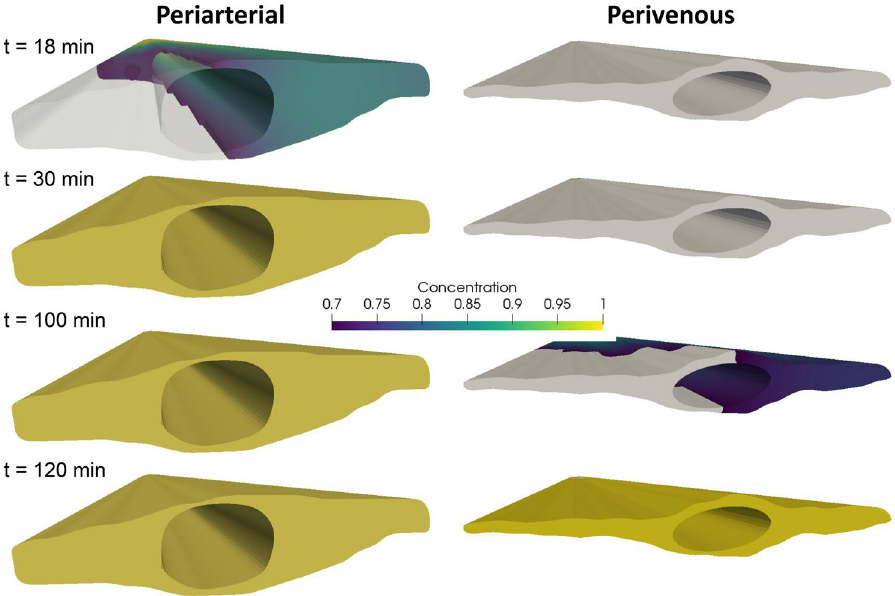
Figure 8. Tracer (2000 kDa) distribution around the artery (left) and the vein (right) at several time points after injection. The front end shows the site of measurement, while the point of injection is in the far end of the geometry. Colors indicate a threshold of 0.7. At 18 min after injection, tracer appears only on the right side of the artery, while after 30 min the concentration in the periarterial space is evenly distributed. After 100 min, the concentration is almost uniform at the cross section at the artery PVS, while the venous PVS is half covered, despite the fact that there is a small path for communication between the PVS on each side of the vessel.